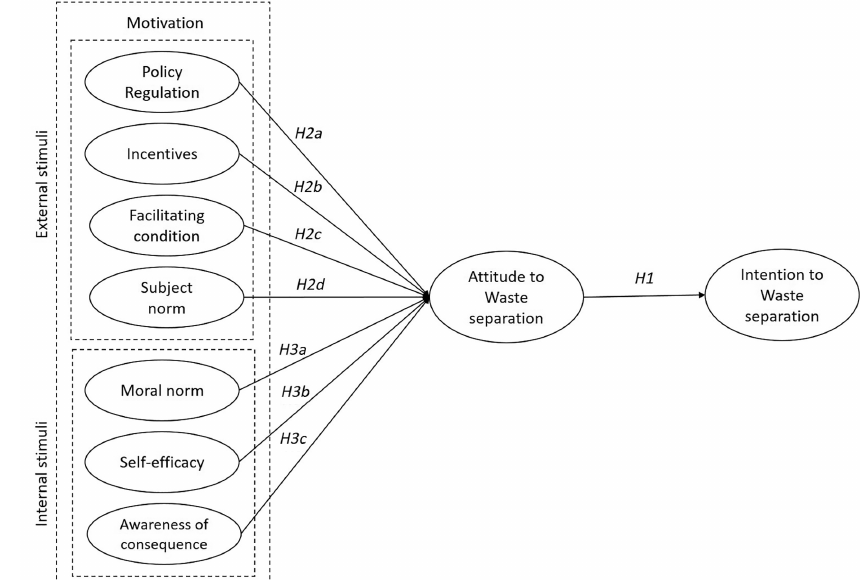
Figure 1. Research model in current